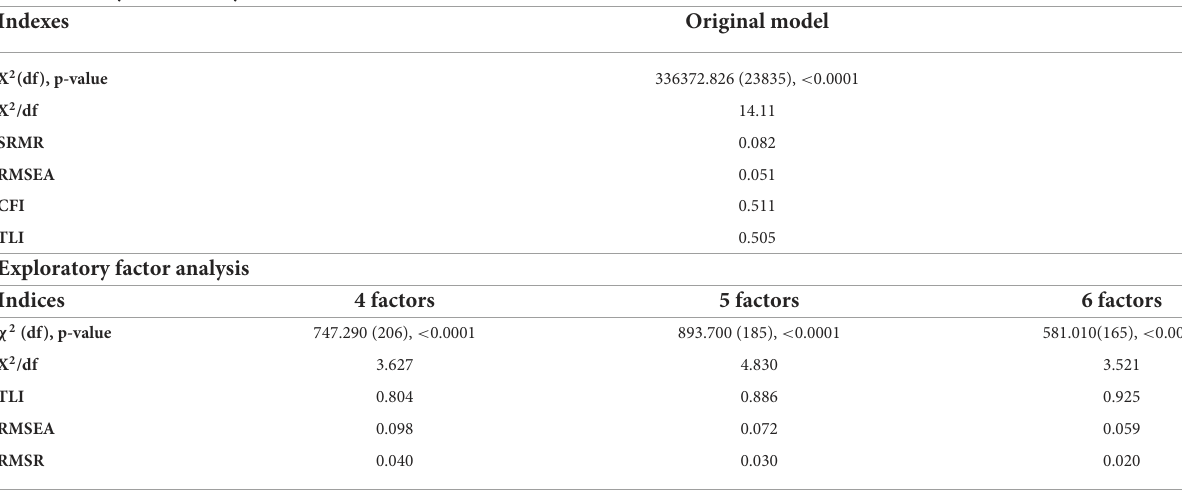
TABLE 4 PID-5 (paper-and-pencil) confirmatory and exploratory factor analysis of goodness of fit indexes ( N = 730). Confirmatory factor